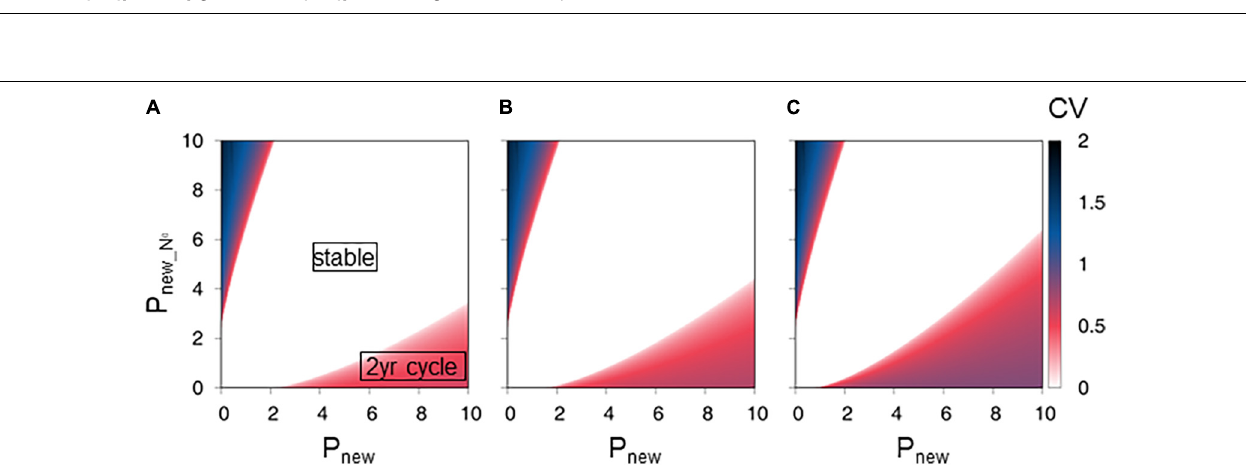
Frontiers in Forests and Global Change |